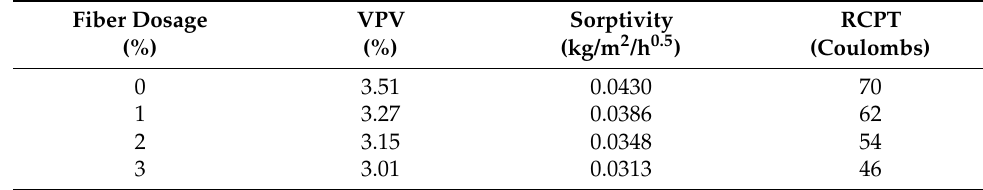
Table 5. Durability properties of UHPC